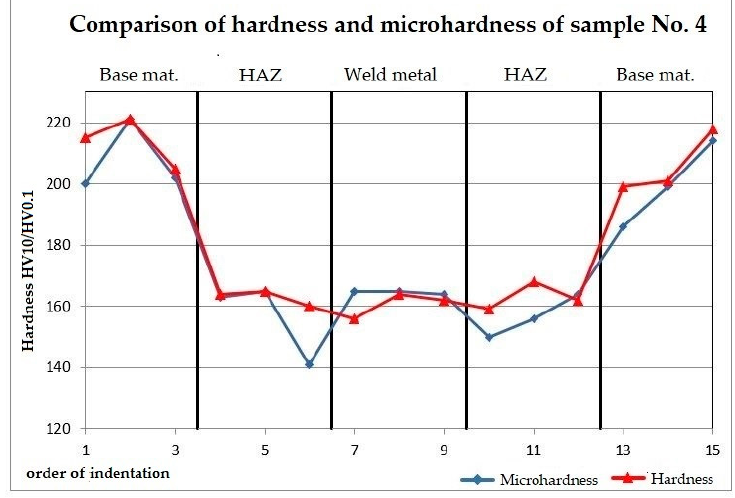
Figure 11. Comparison of hardness and microhardness of sample No. 4.